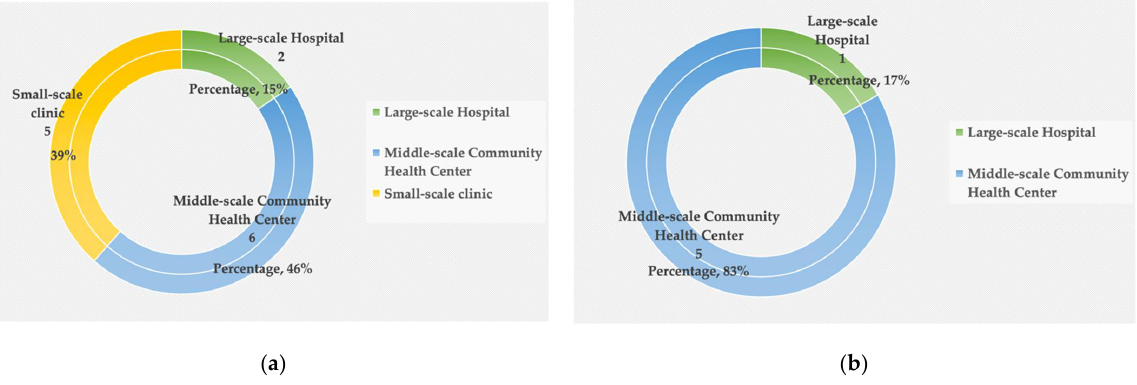
Figure 4. Number of healthcare facilities: ( a ) number of each type of healthcare facility on the north side Fuxingmenwai Street; ( b ) amount of each type of healthcare facility southside of Fuxingmenwai Street. Table 1. Areas of health centers and service targets of Yuetan